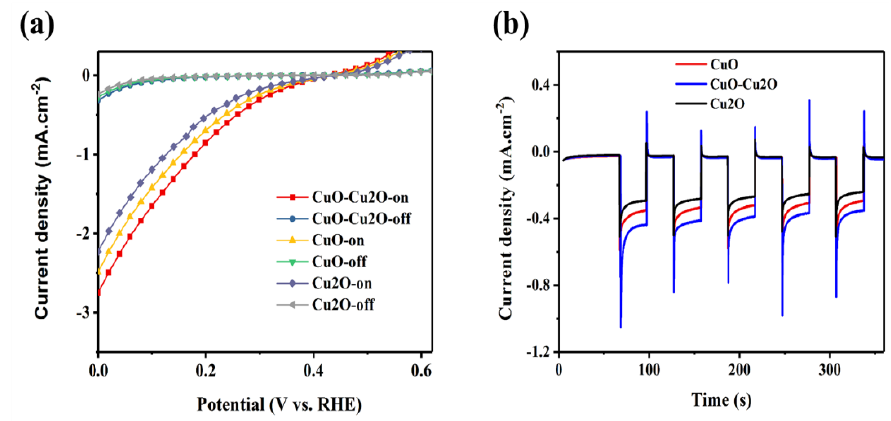
Figure 8. ( a ) photoelectrochemical (PEC) current density and ( b ) photocorrosion stability of the control CuO and Cu 2 O photocatalysts and CuO–Cu 2 O photocatalyst.